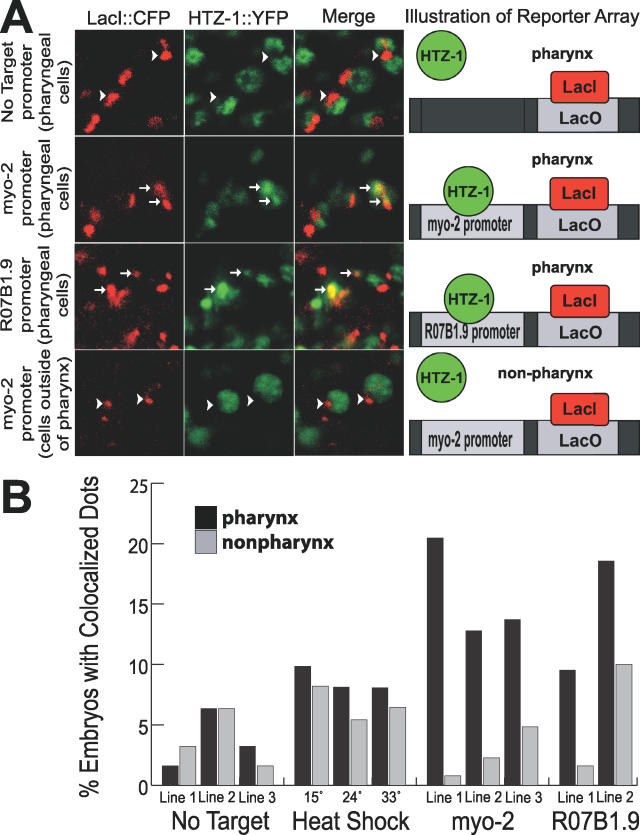
Association of YFP::HTZ-1 with Pharyngeal Promoters(A) Extrachromosomal target arrays were visualized by LacI::CFP (red) bound to the Lac operator (LacO). YFP::HTZ-1 (green) was excluded (arrowheads) from arrays with no-target promoter (row 1), but associated with target arrays containing promoters for pharyngeal genes myo-2 or R07B1.9 in pharyngeal cells (rows 2 and 3). Merge is yellow. YFP::HTZ-1 was excluded from arrays containing the myo-2 promoter in non-pharyngeal cells (row 4). Cartoons depict interpretation of data.(B) Percentage of embryos containing one or more co-localized LacI::CFP and YFP::HTZ-1 dots in the pharynx (black) or outside of the pharynx (grey). Association was significantly higher in the three myo-2 promoter lines (p < 0.0001) and two R07B1.9 lines (p = 0.0014). No significant difference in association was found when comparing the no-target lines to the heat-shock promoter target at 15 °C, 24 °C, or heat-shock at 33 °C for 30 min (p > 0.095). More than 60 embryos were scored for each no-target, heat-shock, and R07B1.9 line. More than 120 embryos were scored for each myo-2 line. YFP::HTZ-1 association was predominantly pharyngeal for myo-2 (p < 0.0001) and R07B1.9 (p = 0.0407) target arrays, but not control arrays (p = 1.00). An equivalent number of images were taken at the 1.5-, 2-, and 3-fold stages of embryogenesis for each line. The p-values were calculated using Fisher exact test.